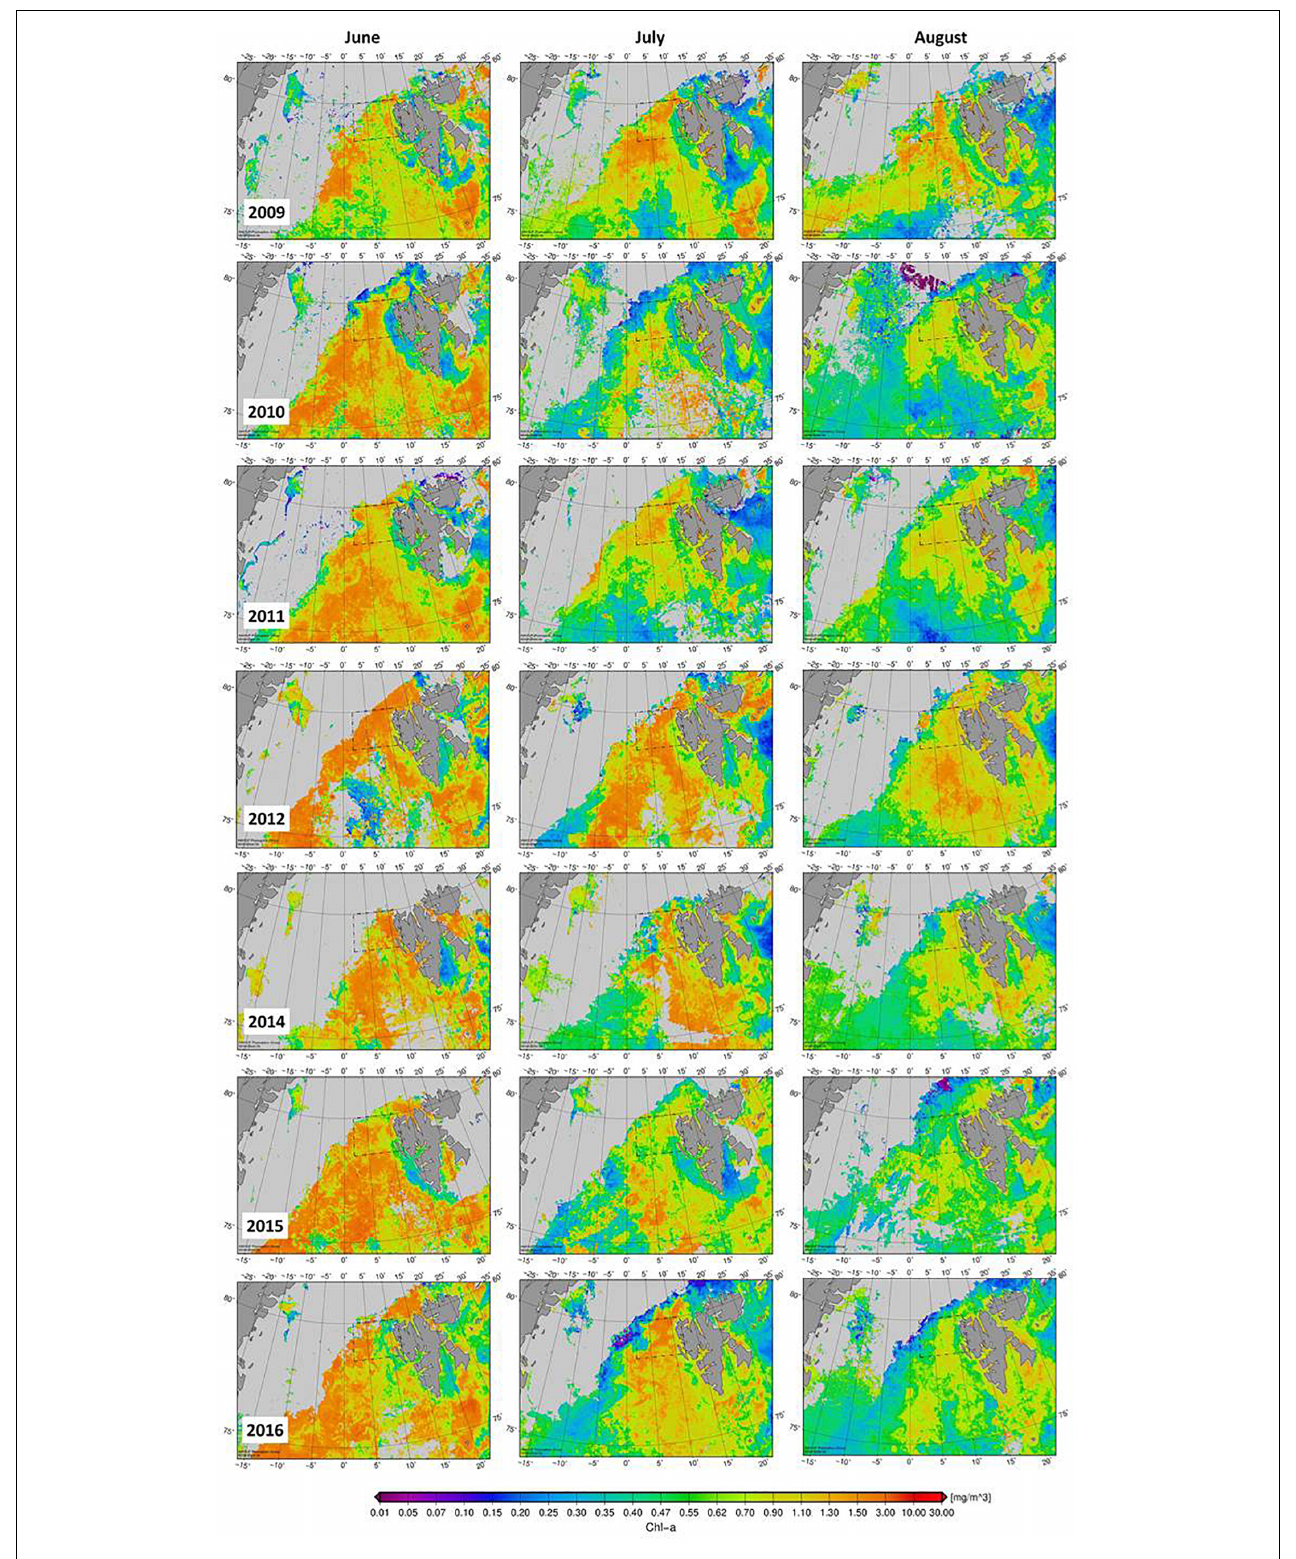
FIGURE 3 | Spatial variability of satellite derived Chl- a concentration (mg m − 3 ) in the Fram Strait during summer months (June–August) when sampling has been conducted. No cruise was conducted in 2013; data not available for 2017. Land area is indicated by dark gray shade, cloud coverage by lighter gray.